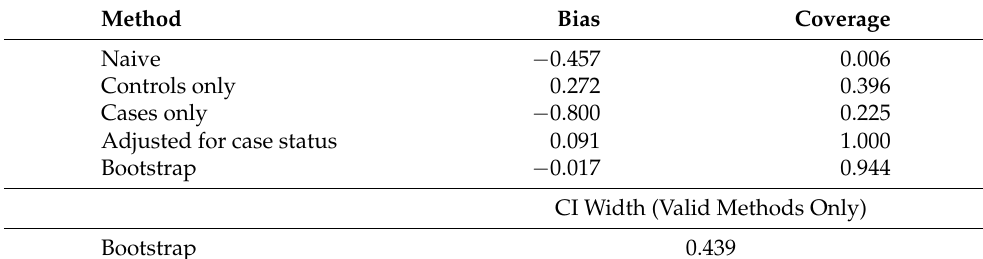
Table 3. Results of simulations for intermediate time-to-event